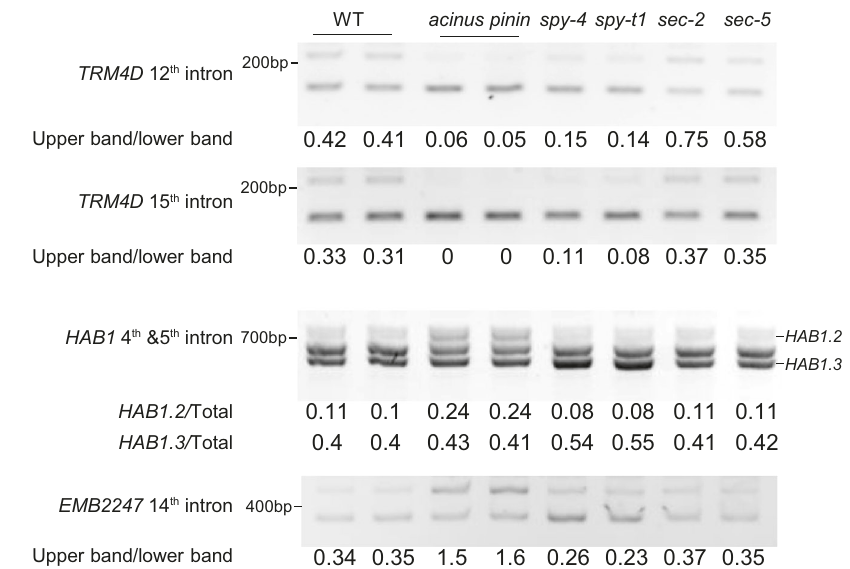
Fig. 6 A subset of AtACINUS-dependent intron splicing events are affected in the spy and sec mutants. RT-PCR of HAB1 , EMB2247 , and TRM4D in 7- day-old WT, acinus-2 pinin , spy-t1 , spy-4 , sec-2 , and sec-5 seedlings with primers fl anking the targeted